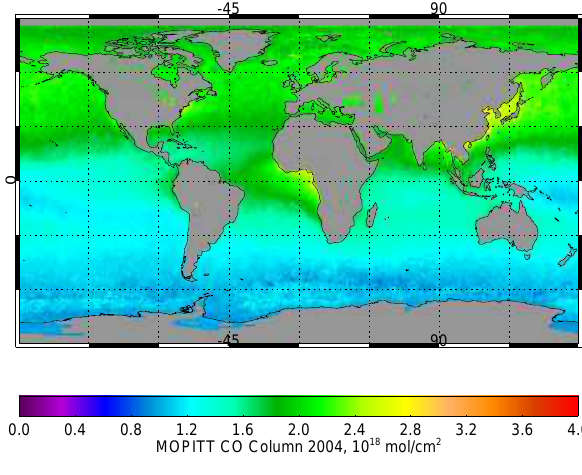
Fig. 4. Plot of wind direction θ max for the locations where σ τ is greater than 0.035. Rectangular show regions discussed.